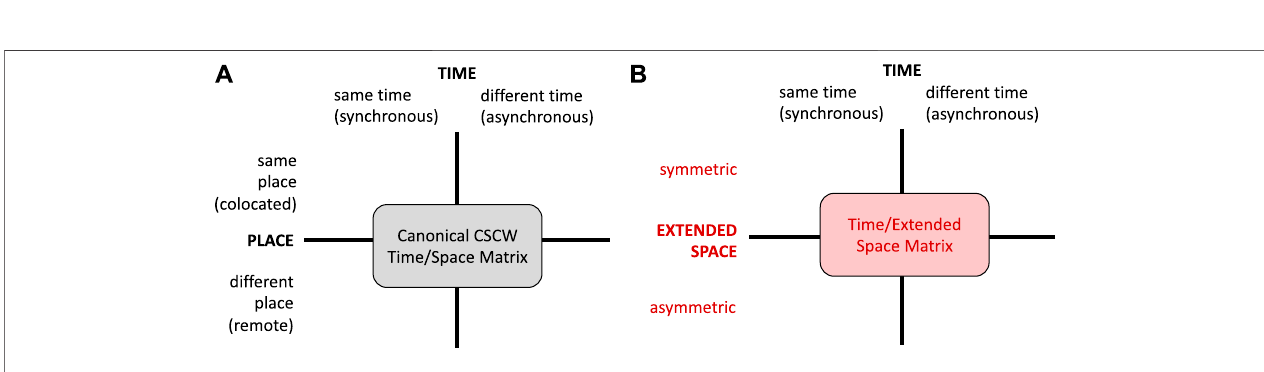
FIGURE1| ThreeexamplescenariosthathavenomeaningfulplaceinthecanonicalCSCWmatrix(1)Auserwatchingavideomirrorofaco-locatedVRuser.(2)an AR user and another user who does not wear a headset, (3) two remotely located VR users who are part of the same virtual scene.